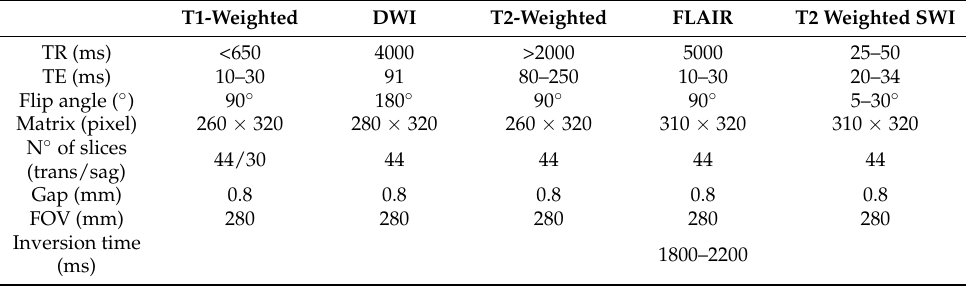
Table 2. Brain MRI scan